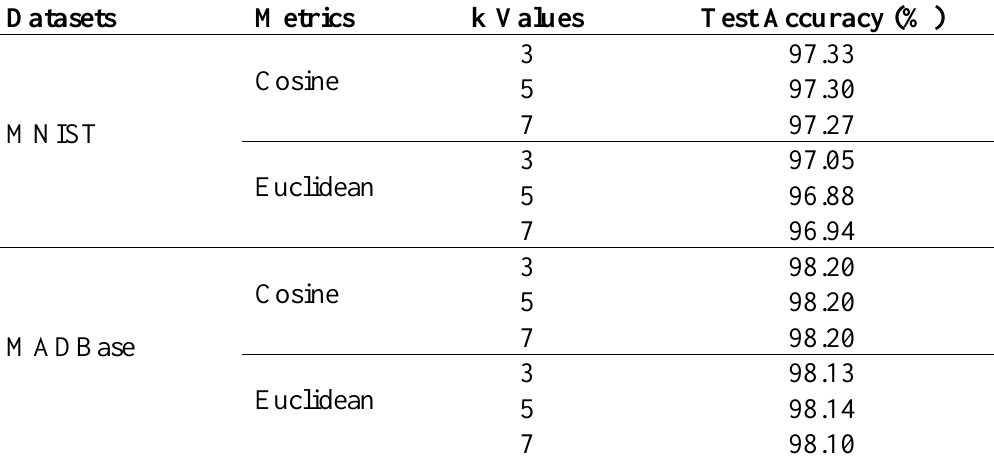
Table 1 . Classification results with the KNN method